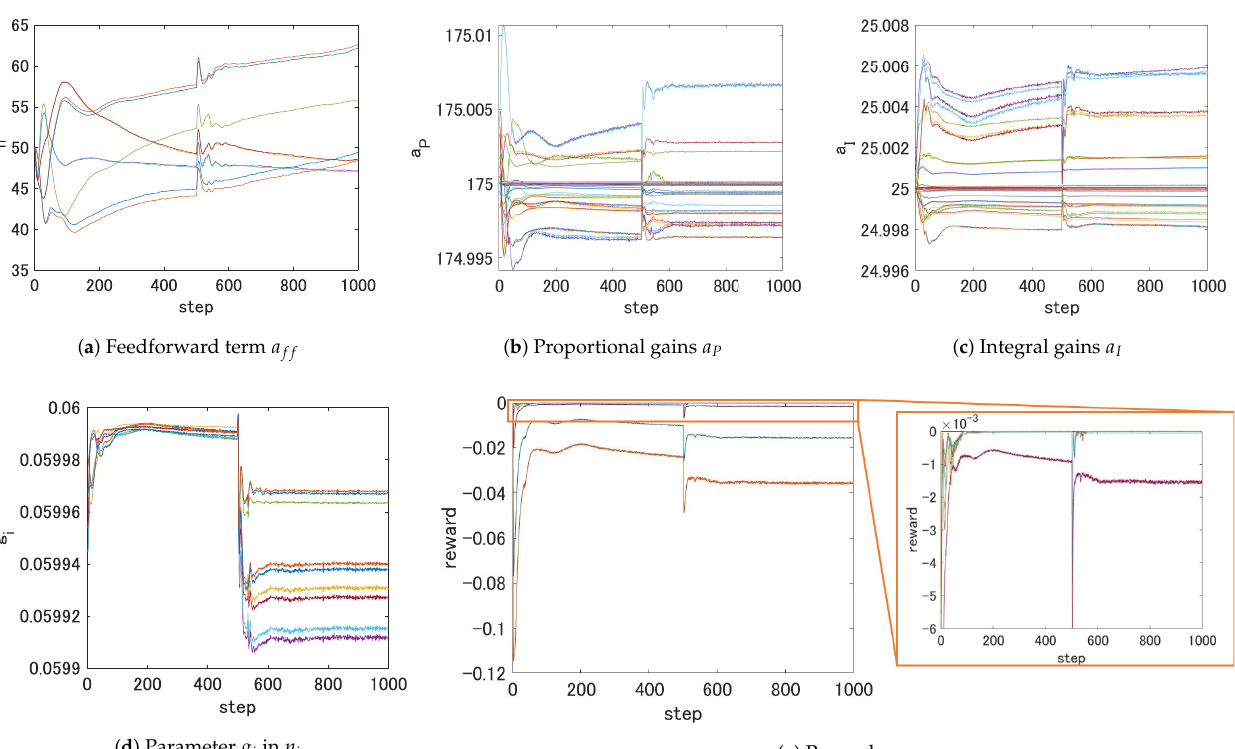
Figure 12. Changes of the quantities related to the self-tuning functionality of the proposed control system under the reference modification scenario.